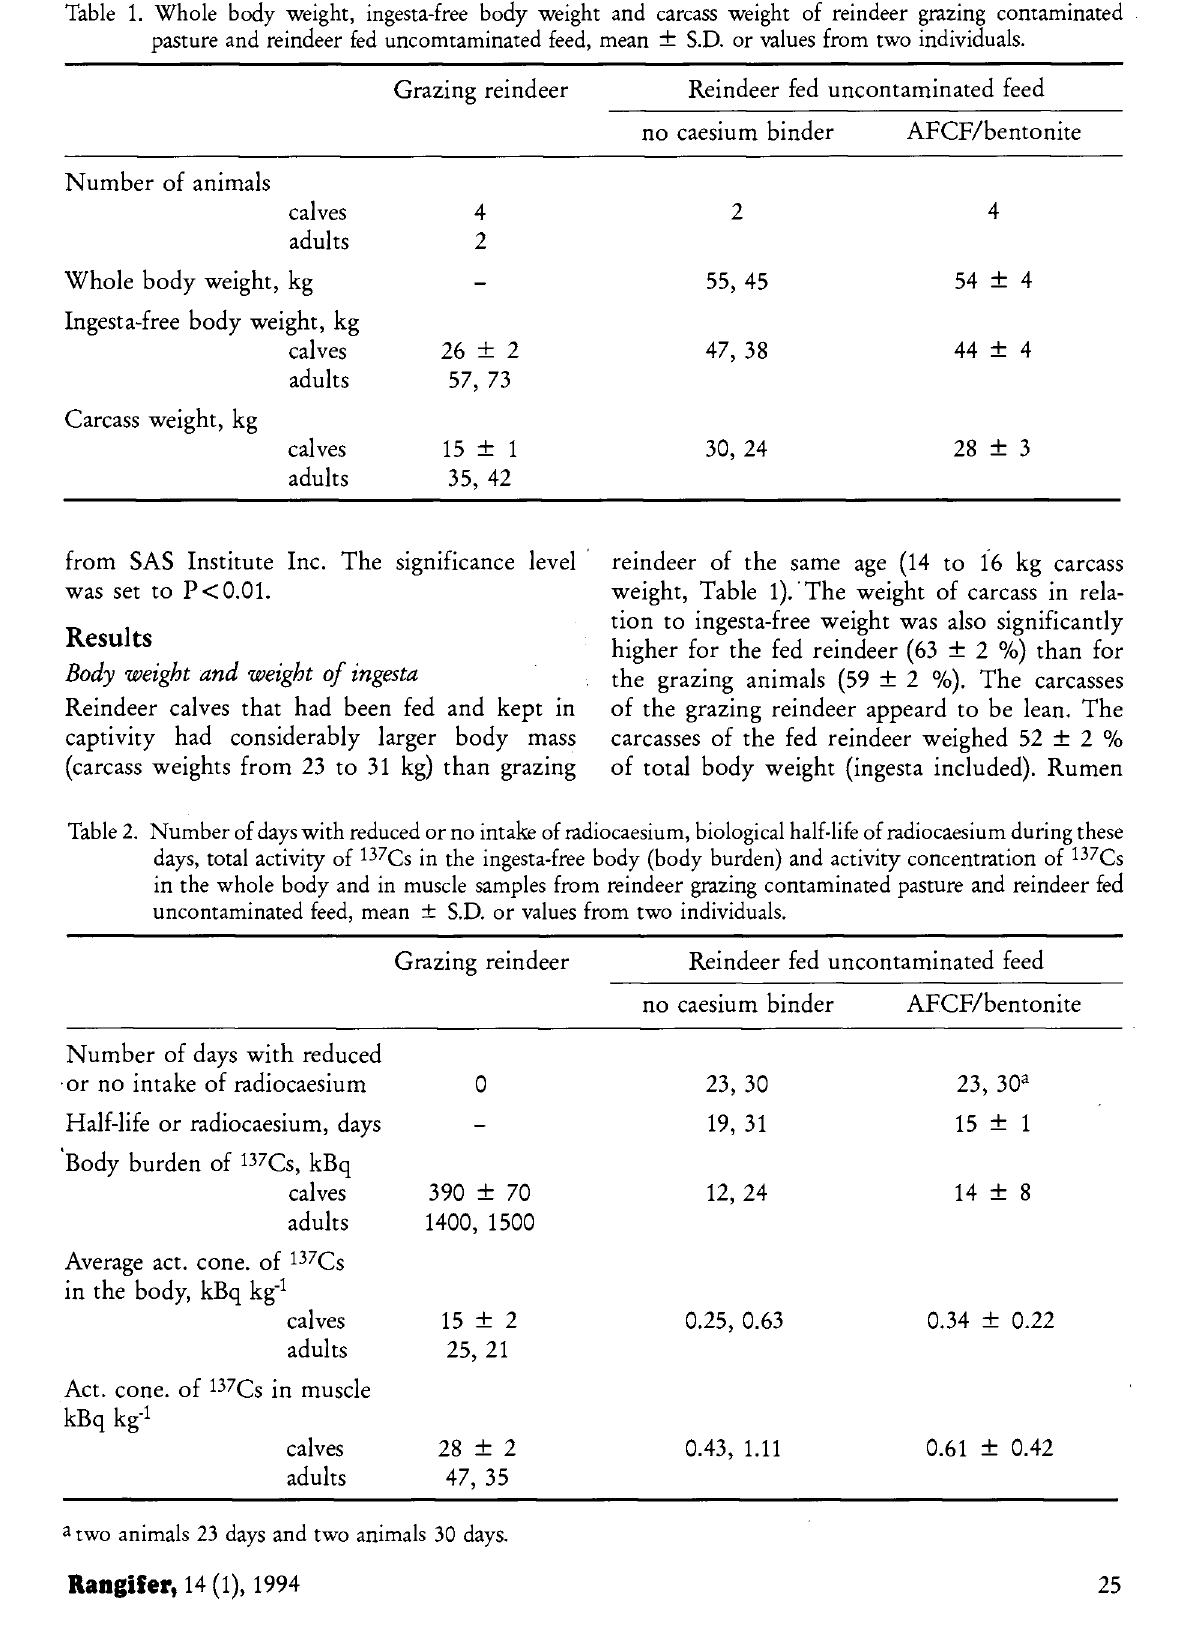
Table 2. Number of days with reduced or no intake of radiocaesium, biological half-life of radiocaesium during these days, total activity of 137 Cs in the ingesta-free body (body burden) and activity concentration of 137 Cs in the whole body and in muscle samples from reindeer grazing contaminated pasture and reindeer fed uncontaminated feed, mean ± S.D. or values from two